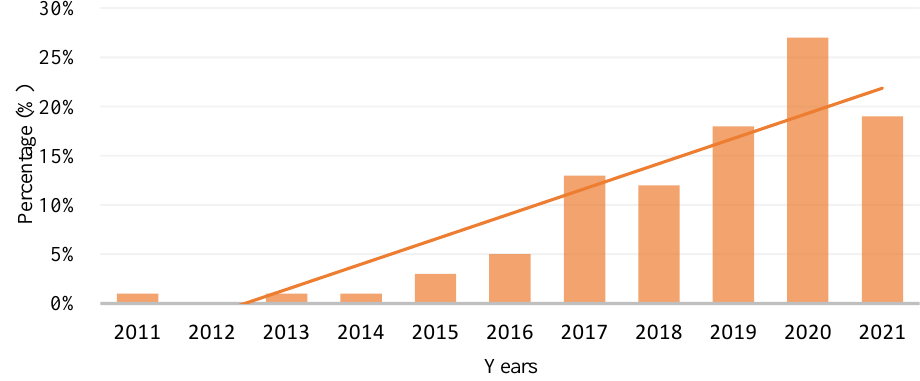
Figure 20. The trend of polymer composition utilisation in FDM from year 2011 to 2021.